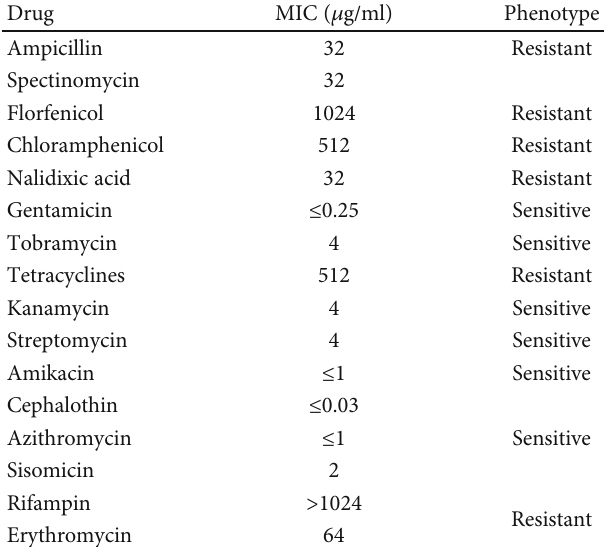
Table 2: Antibiotic resistance pro fi le of R50.